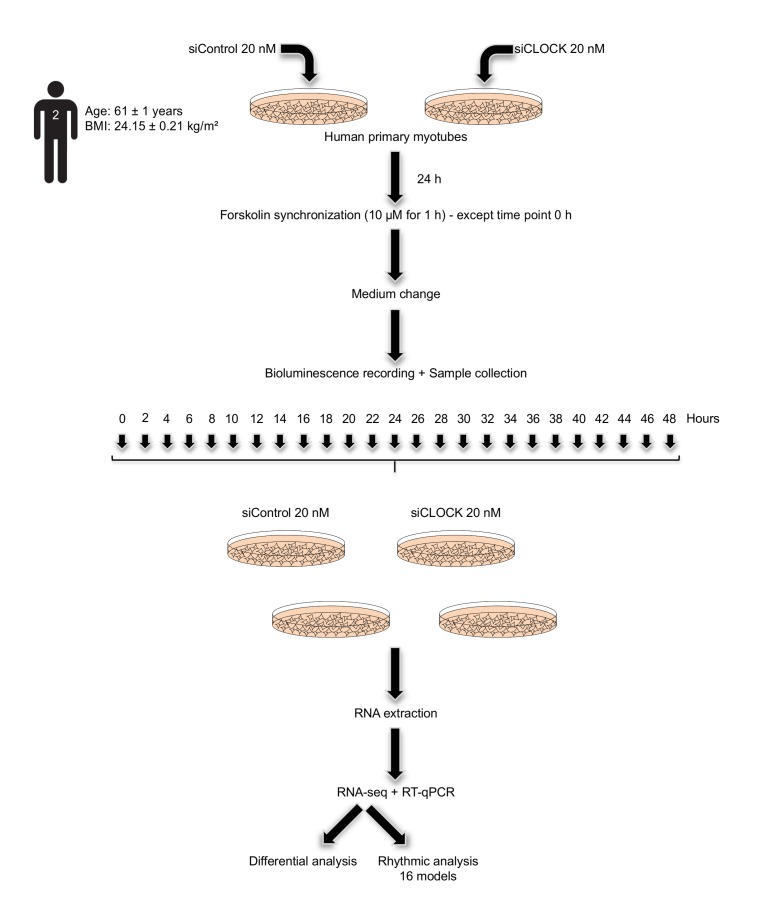
Study design.Primary human myotubes were transfected with 20 nM of non-targeting siRNA (siControl) or with same amount of siCLOCK at day 6 of differentiation. 24 hr following siRNA transfection, in vitro synchronization by 10 µM forskolin pulse during 1 hr was conducted for all the dishes, except for those collected at time point 0 hr. Cells were harvested in duplicate dishes for each time point and for each donor, every 2 hr during 48 hr. Extracted RNA samples were subjected to RNA sequencing analysis or to real-time quantitative PCR (RT-qPCR).